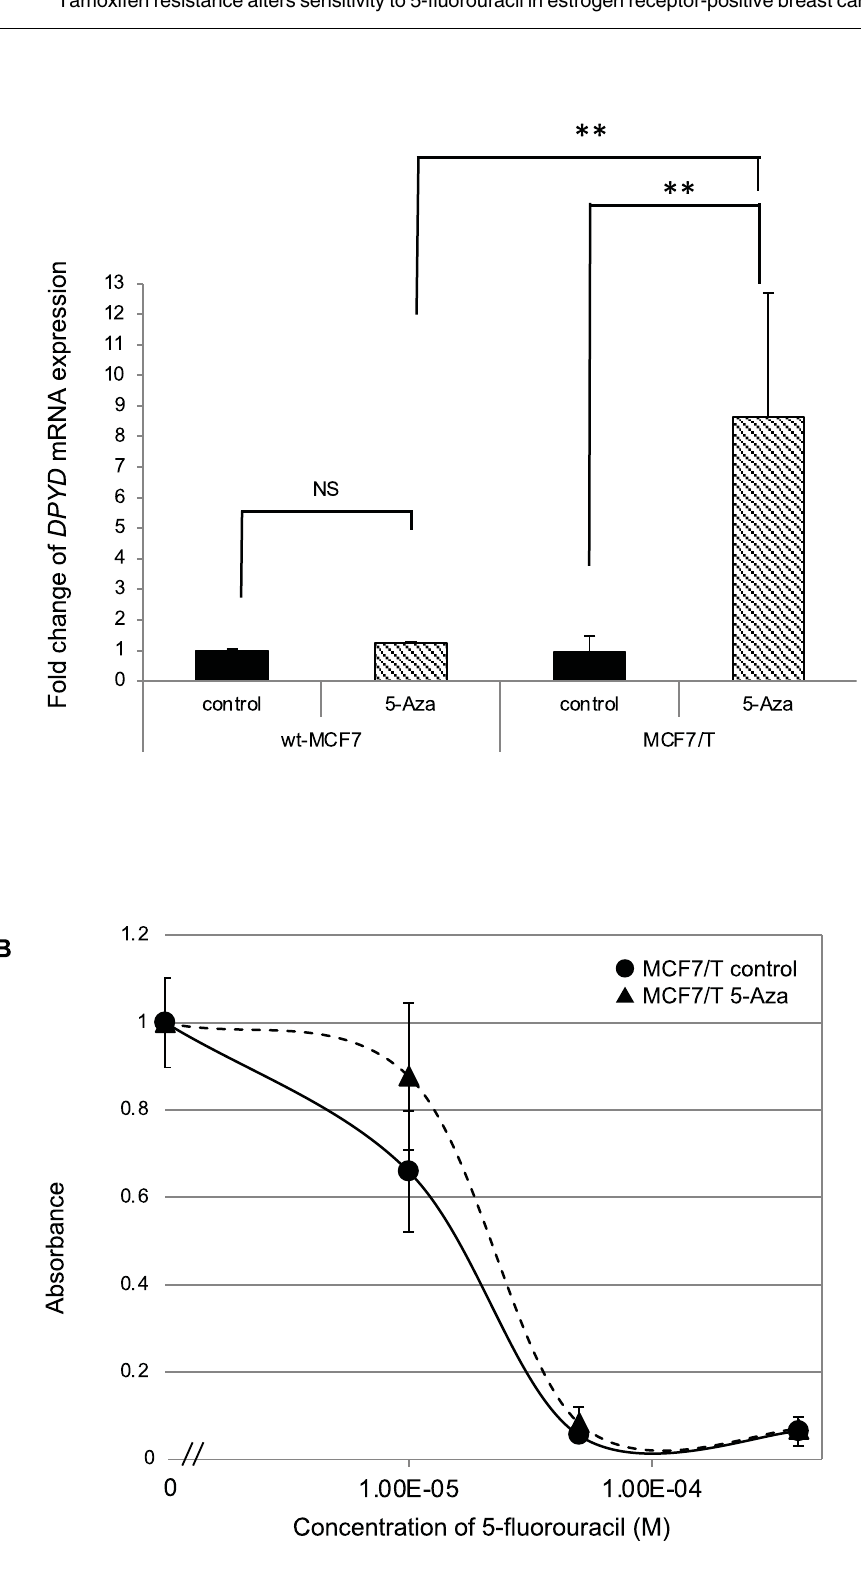
Fig 6. Effects of a demethylating agent on DPYD mRNA expression and sensitivity to tamoxifen in wild-type MCF7 and tamoxifen-resistant MCF7 cells. Alteration of DPYD mRNA expression and sensitivity to 5-fluorouracil exerted by a demethylating agent, 5-azacytidine, was tested in wild-type and TAM-resistant MCF7 (MCF7/T) cells. (A)